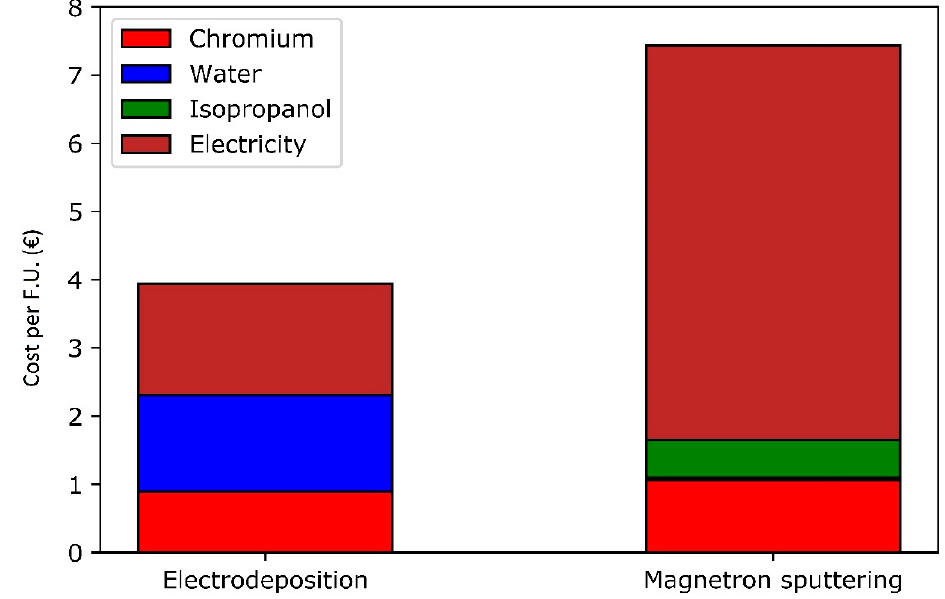
Figure 7. Operating costs for one functional unit for electrodeposition and magnetron sputtering (salaries excluded).